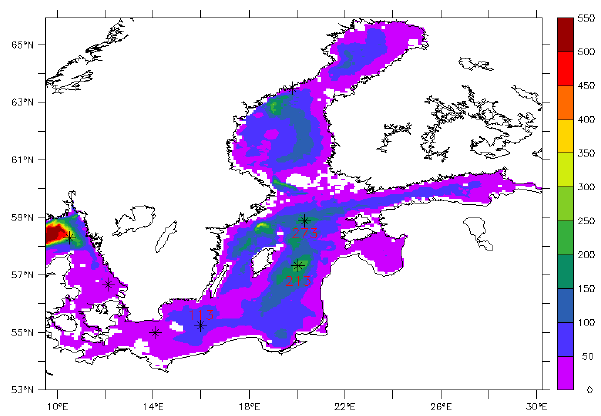
Fig. 1. Bathymetry of the Baltic Sea (unit: m) and locations of selected observation stations. Data from stations (*) are used for Table 2. Time-series of data are collected from Stat. 113 (Arkona Basin), Stat. 213 (Bornholm Basin), and Stat. 271 (Gotland